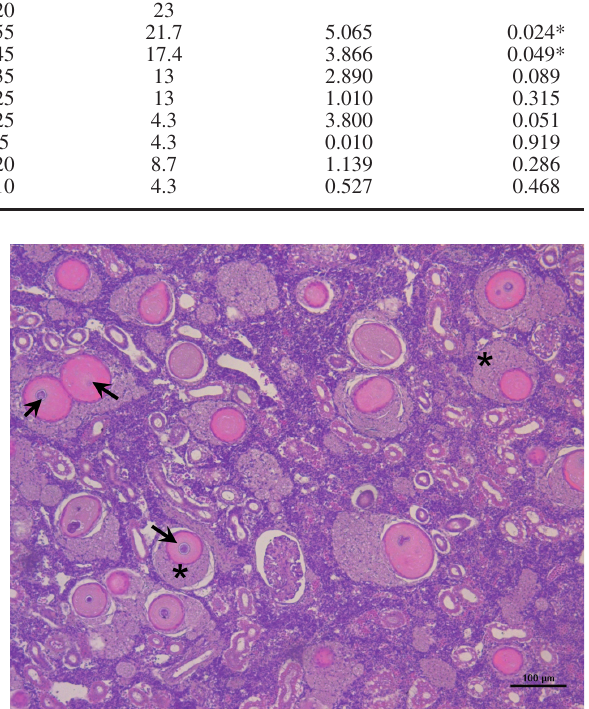
Fig . 3. – Ichthyophonosis in kidney of Citharus linguatula . Arrows, spores of Ichthyophonus sp.; asterisks, macrophage aggregates of